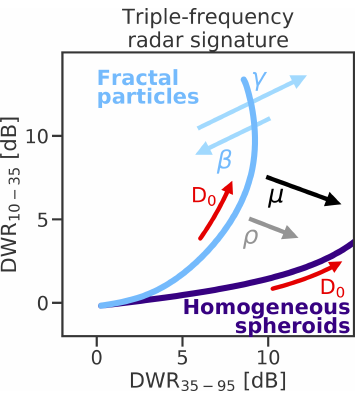
Figure 5. A schematic for the parameters affecting the triple- frequency radar signature of a spectrum of ice particles. In addition to the median volume diameter and density, the effects of the in- ternal structure of aggregate particles and the PSD shape parameter are illustrated (cf. Kneifel et al.,